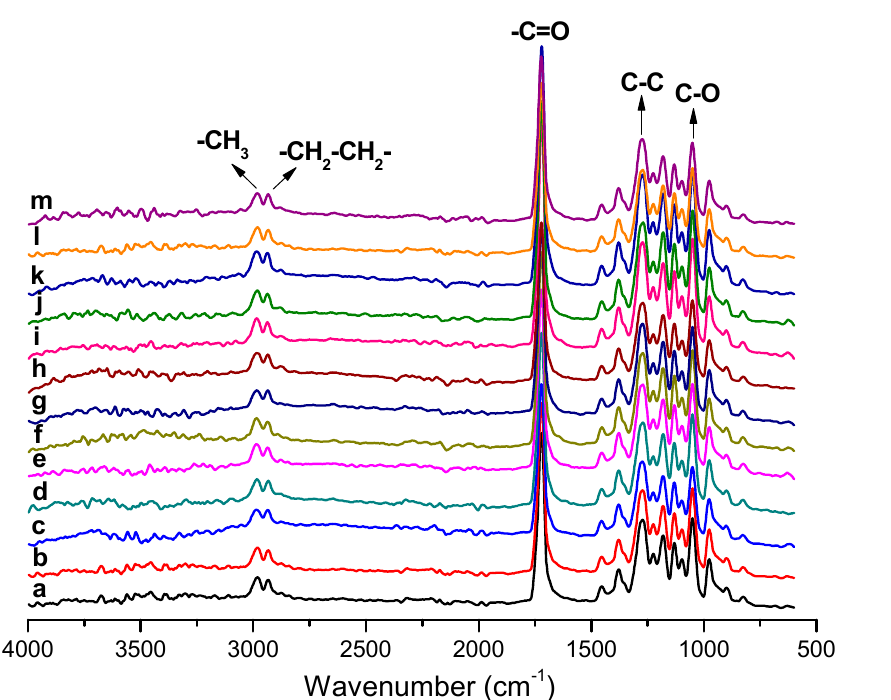
Figure 10. ATR-FTIR spectra of cerium oxide nanoparticles (CeO 2 NPs). The spectra were acquired between a 4000 and 600 cm − 1 wavenumber.